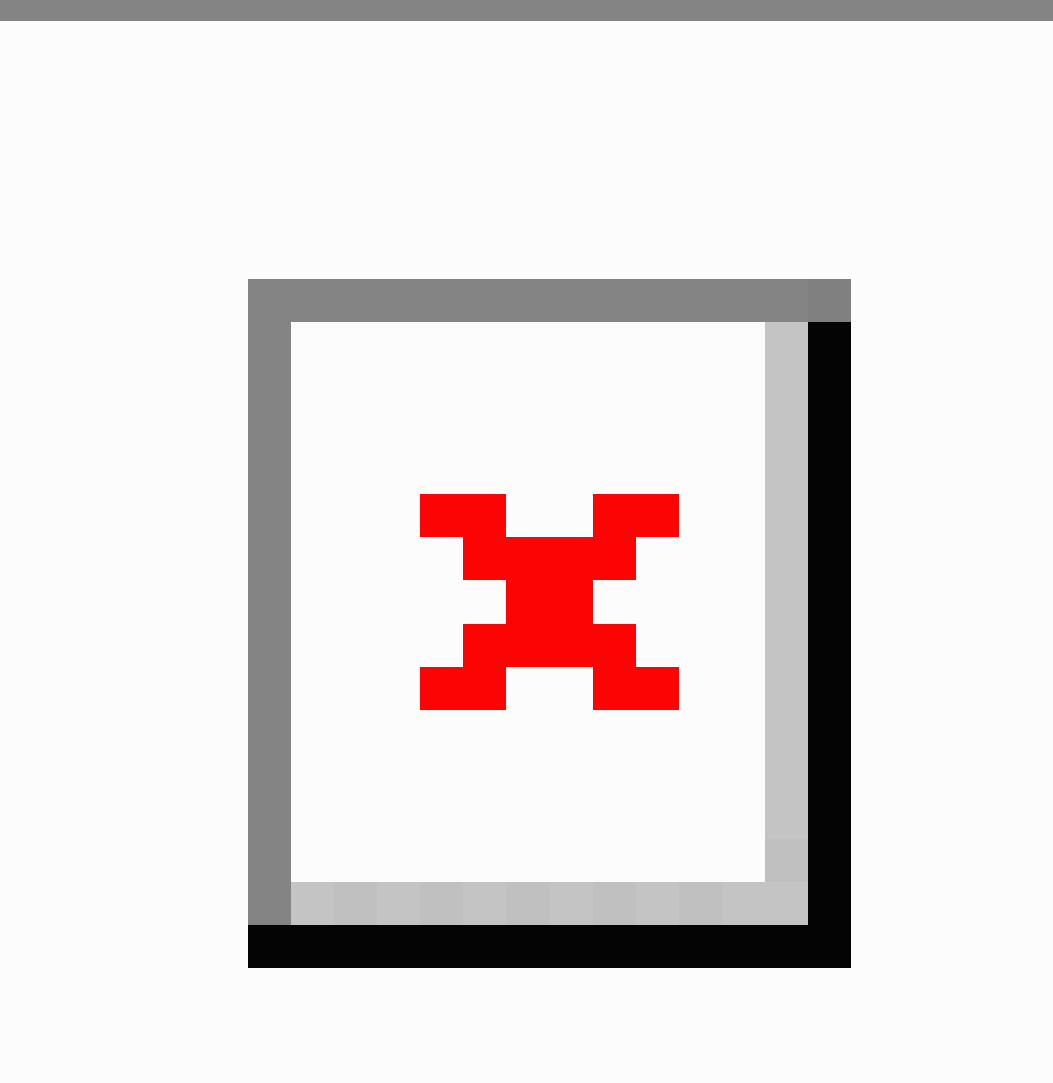
Figure 6. Forest plot of the odds ratio (OR) in patients with hypertension who achieved the prespecified target blood pressure and who were involved in randomized controlled trials comparing a mobile phone intervention versus control. The estimate of the OR of each trial corresponds to the middle of the squares, and the horizontal line shows the 95% CI. The summary OR is represented by the middle of the solid diamond. A test of heterogeneity is given below the summary statistics. MPI: mobile phone intervention, df: degrees of